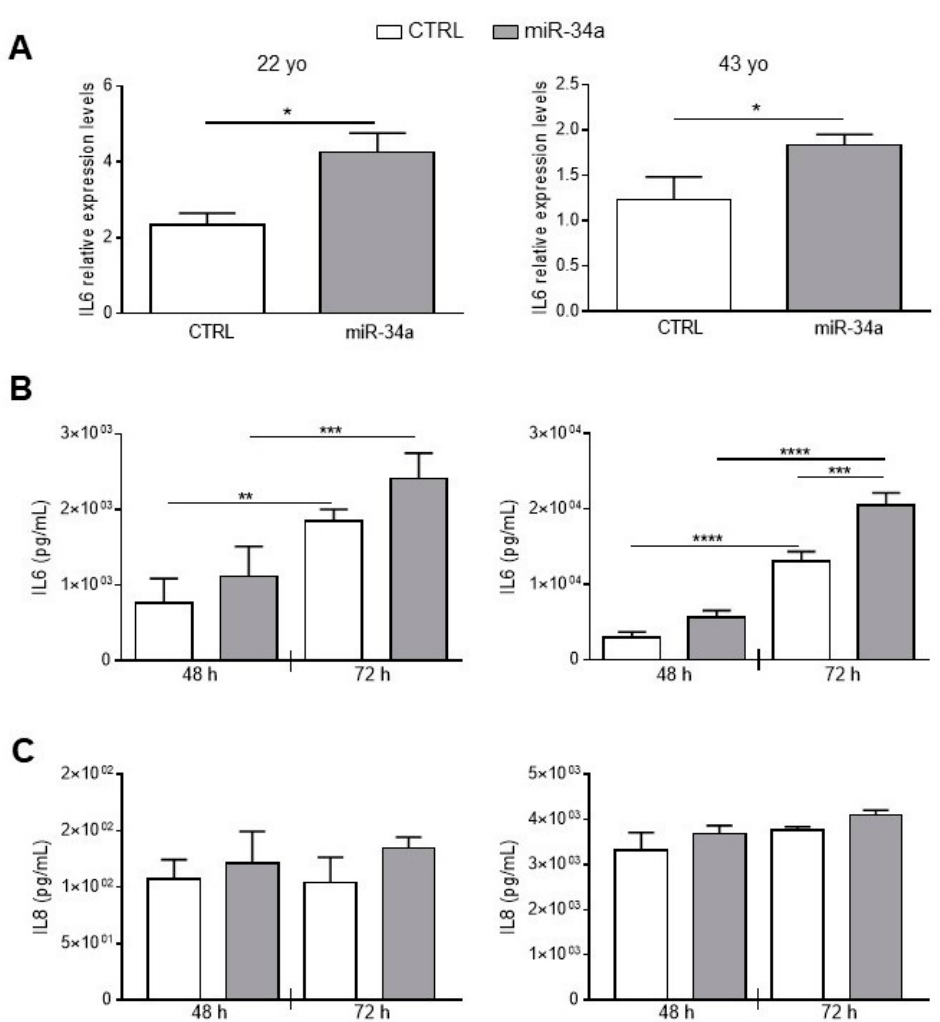
Figure 2. IL6 and IL8 expression and secretion increases upon miR-34a overexpression in HASMCs. HASMCs of 22- or 43-year-old donors were infected with either pMIRNA1 (CTRL) or pMIRH34a (miR-34a) lentivirus. ( A ) HASMCs were cultured in a growth medium for 48 hour. IL6 expression was quantified by qRT-PCR and normalized to corresponding HPRT levels. Values are mean ± SD; *, p < 0.05; Student’s t -test; n = 3–4. ( B ) HASMCs were cultured in growth medium for 48 and 72 hours (h). Amount of IL6 was quantified by ELISA assay in the supernatant of cells. Values are mean ± SD; **, p < 0.01; ***, p < 0.001; ****, p < 0.0001; 1-way ANOVA followed by Bonferroni’s multiple comparison test; n = 3–4. ( C ) HASMCs were cultured in growth medium for 48 and 72 h. Amount of IL8 was quantified by ELISA assay in the supernatant of cells. Values are mean ± SD; 22 yo, n = 5; 43 yo, n = 3. As a check of the specificity of the effect of miR-34a, we evaluated secretion of Interleukin 8 (IL8). No significant changes were observed in IL-8 production after miR-34a overexpression in HASMCs from the 22- and the 43-year-old donors at 48 and 72 h after infection (Figure 2C). Similarly to IL6,